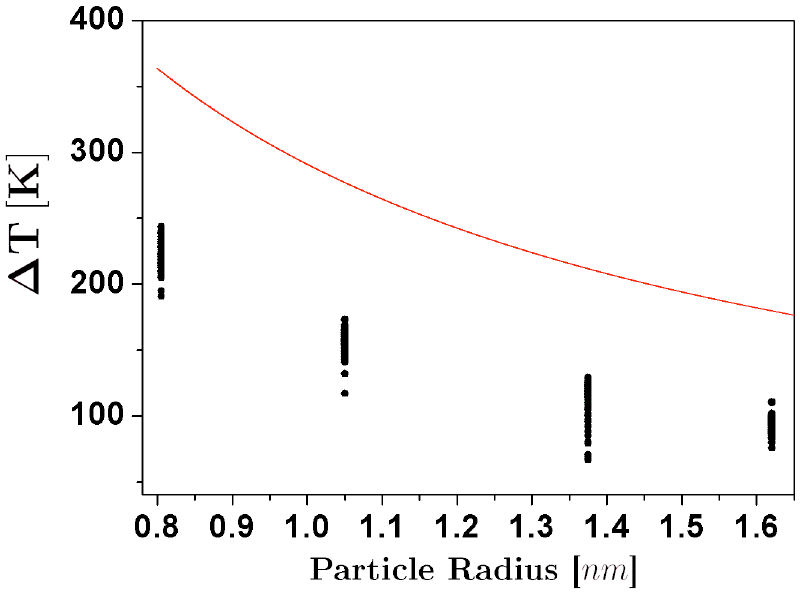
Figure 2. Temperature increase due to the coalescence of icosahedral nanoparticles, as a function of the size of the coalescing particles. The dots represent the simulations results, and the dotted line is the expected behavior of ∆( T ) , assuming sphericity and bulk values of surface tension, heat capacity, and